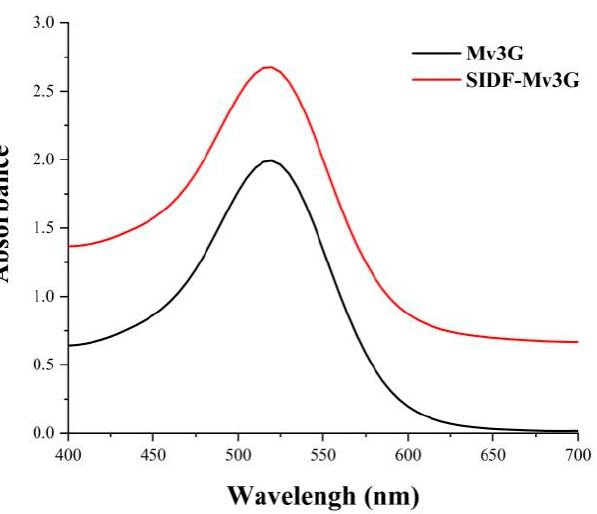
Figure 4. Ultraviolet–visible spectra. SIDF-Mv3G: the stability system solution of soybean insoluble